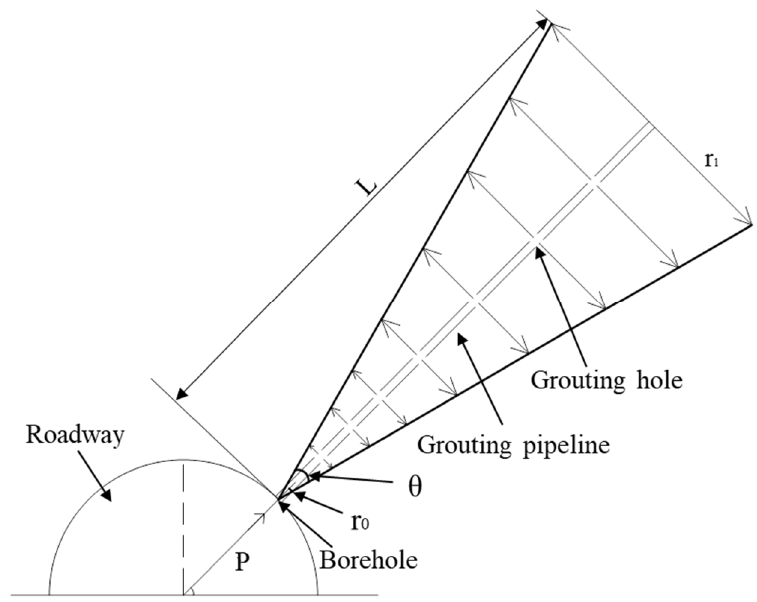
Figure 9. Slurry diffusion model.